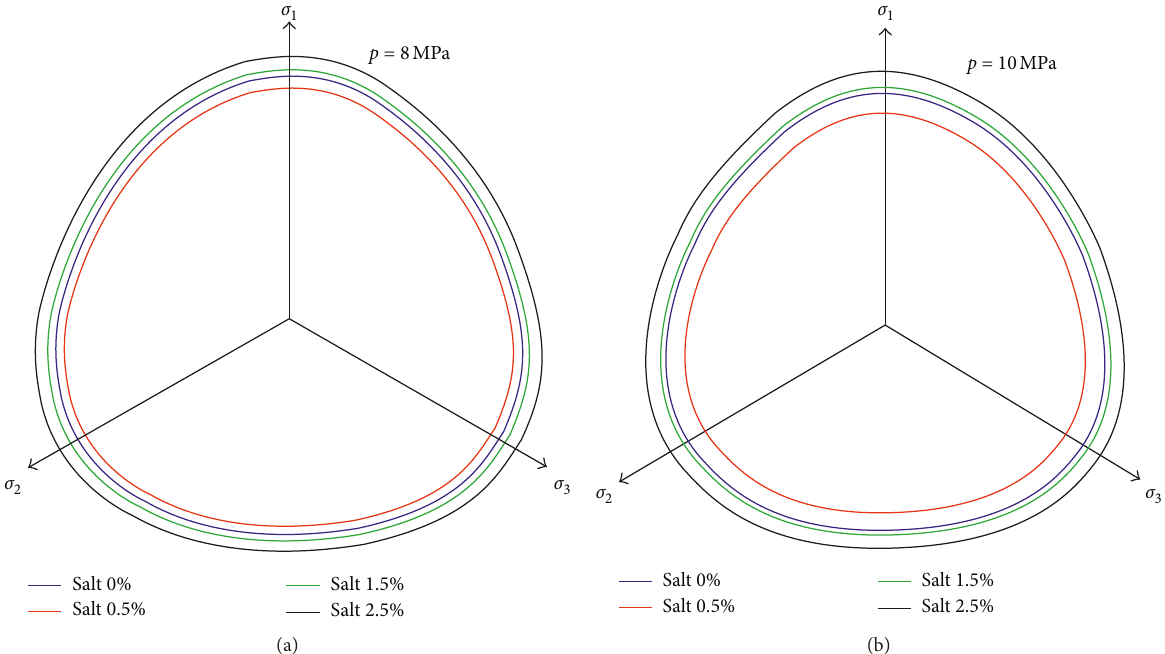
Figure 7: The shape function curves in the π plane with different salt contents: (a) p � 8 MPa; (b) p � 10